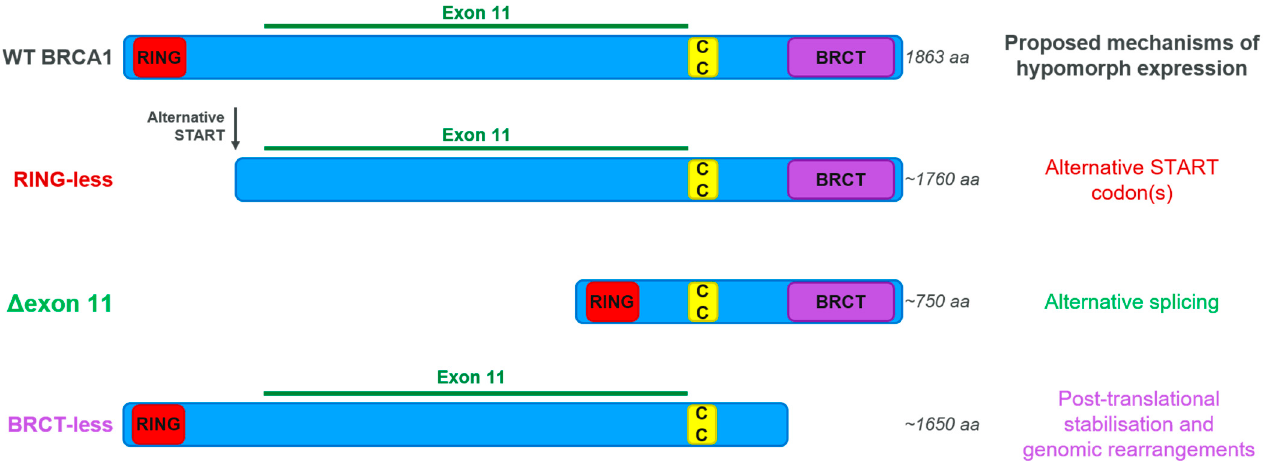
Figure 4. BRCA1 hypomorphs. RING: Really Interesting New Gene domain, with ubiquitin E3 ligase activity. CC: Coiled-Coil region, where BRCA1 interacts with PALB2–BRCA2–RAD51. BRCT: BRCA1 C-Terminus domain, a multi-protein-interacting region.